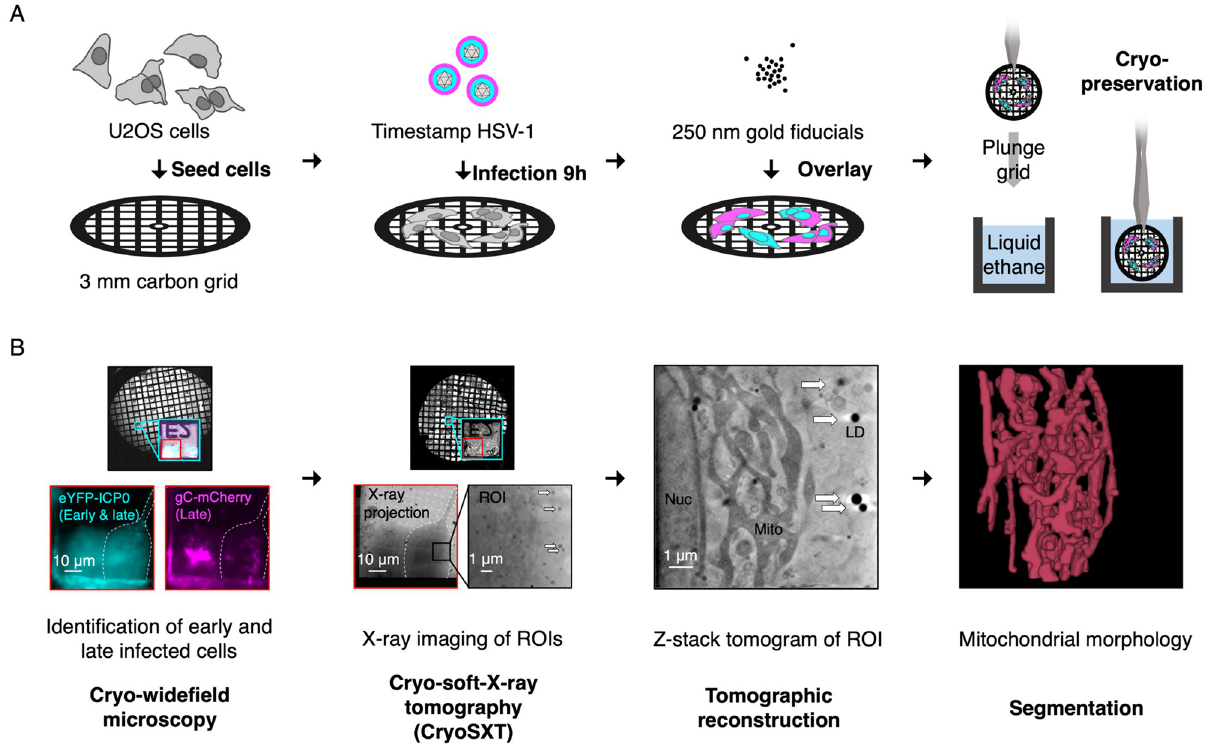
Fig 3. Workflow for multi-modal imaging of HSV-1 infected cells. ( A ) Preparation of infected cells samples for multimodal imaging. U2OS cells are cultured on perforated EM grids and infected with recombinant ‘timestamp’ HSV-1, expressing fluorescently tagged proteins eYFP-ICP0 and gC- mCherry that allow identification of the stage of infection for each cell under investigation. At 9 hpi, gold fiducials are overlayed onto the sample to facilitate image registration and grids are cryopreserved in a near-native state by plunge cryocooling in liquid ethane. ( B ) Multi-modal imaging of infected U2OS cells. A widefield microscope with a cryo stage is used to locate the grid positions of infected cells. The stage of infection for each cell is determined based on the expression of eYFP-ICP0 and gC-mCherry (as shown in Fig 2). These grids are then loaded into the cryo-soft-X-ray microscope at Diamond Light Source beamline B24 and are illuminated with soft X-rays at the marked grid positions. X-ray projections of regions of interest (ROIs) are collected at multiple angles and aligned using the gold fiducials and intracellular features, such as lipid droplets (LDs), with the program IMOD [42]. Tomograms are reconstructed from these projections using IMOD to compare intracellular morphology between uninfected cells and those at early- or late-stages of infection. Segmentation with tools like Contour [60] facilitates quantitation and visualization in three dimensions of the observed cellular